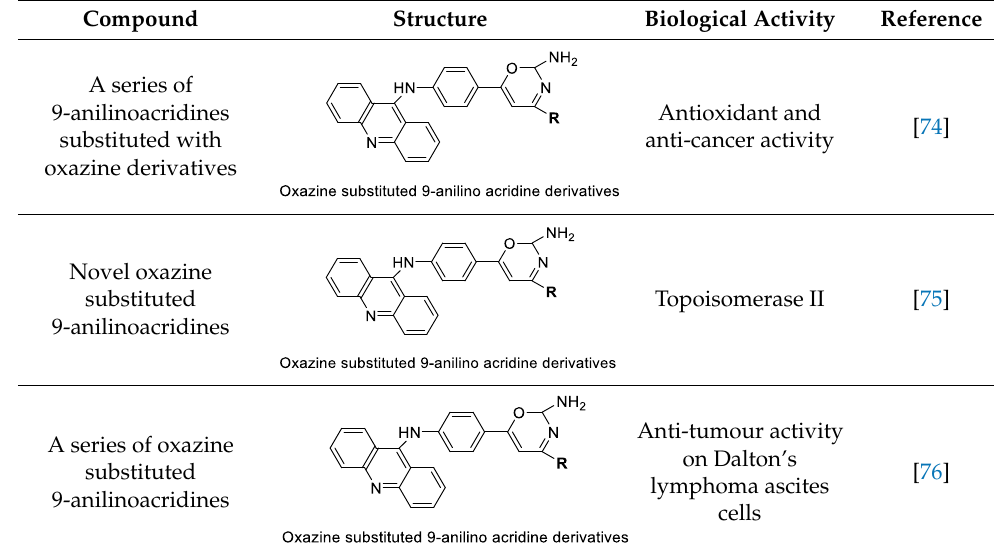
Table 11. Oxazine as an anti-tumour agent.